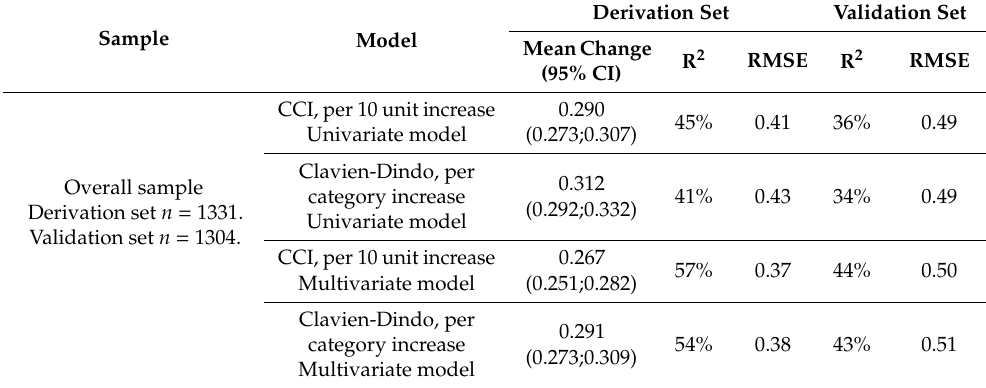
Validation set n =